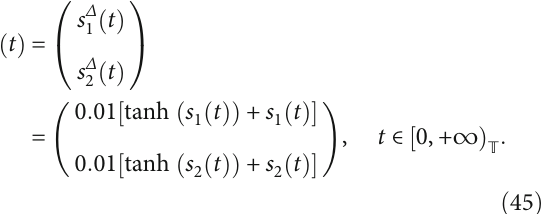
Figure 2: Synchronization error z